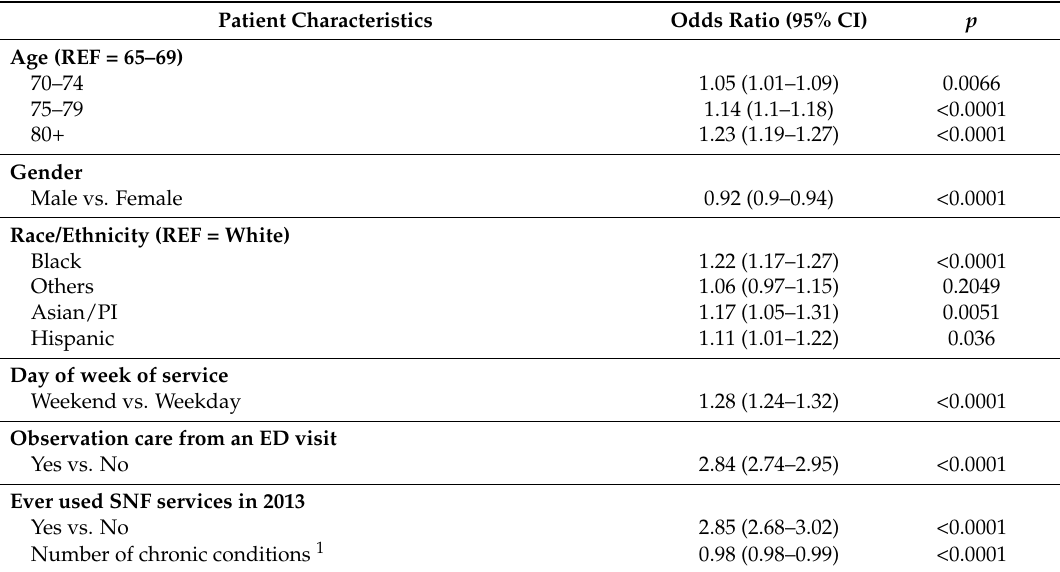
Table 3. GEE logistic regression for unsuccessful observation care